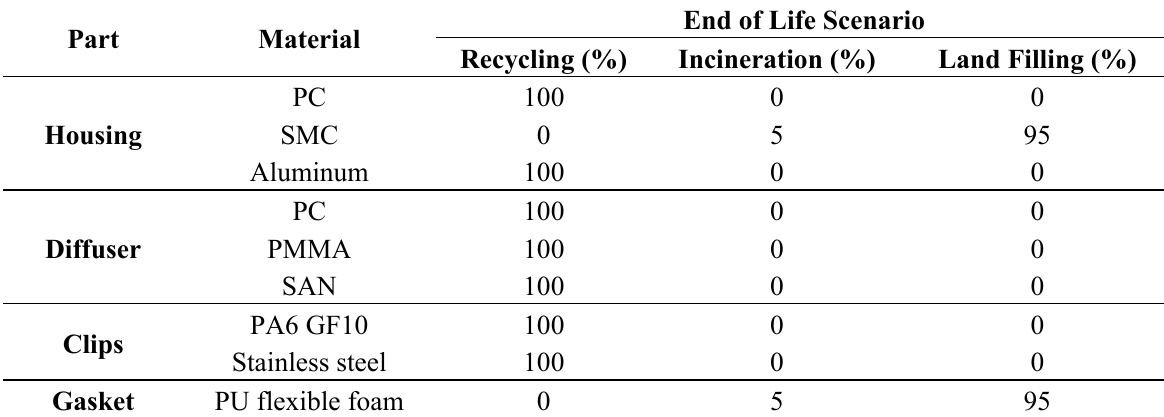
Table 7. End of life Scenario